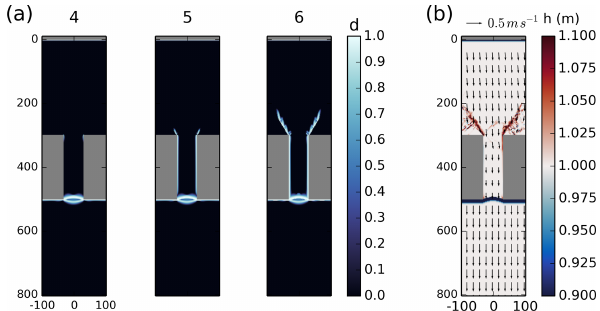
Figure 6. (a) Damage field at the surface forcing indicated by points 4, 5 and 6 in Fig. 4 during the formation of the upstream lines of fracture. (b) Sea ice thickness and drift following the ice bridge collapse (Phase E).